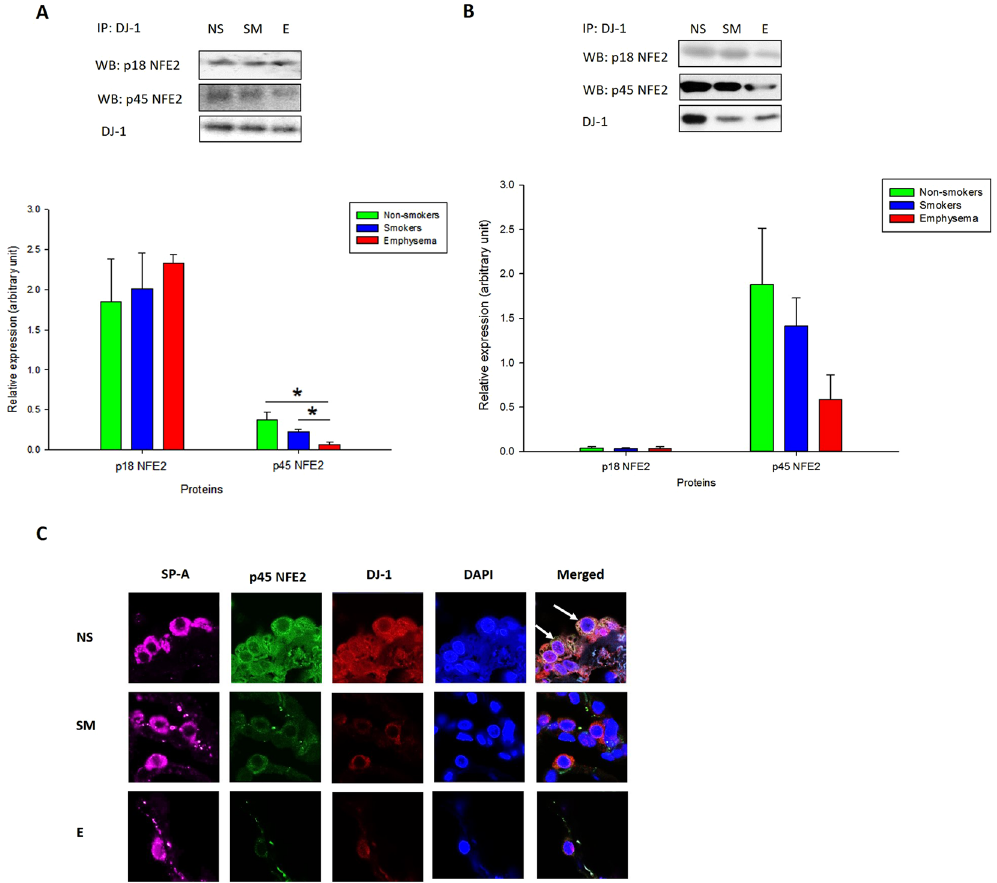
Figure 4. p45 NFE2 interaction with DJ-1 in ATII cells and lung tissue obtained from non-smokers (NS), smokers (SM) and patients with emphysema (E). DJ-1 was co-immunoprecipitated in freshly isolated ATII cells ( A ) or lung tissue ( B ) followed by Western blotting analysis to determine its interaction with p45 NFE2 or p18 NFE2 as described in Materials and Methods. Relative expression is also shown. ( C ) p45 NFE2 (green) and DJ-1 (red) expression in ATII cells identified using SP-A staining (violet) in lung tissue by immunohistofluorescence. Cell nuclei were stained with DAPI (blue). The strongest co-localization of p45 NFE2 and DJ-1 is indicated by white arrows. * Statistically significant difference ( p < 0.05). Data are shown as the mean ( ±